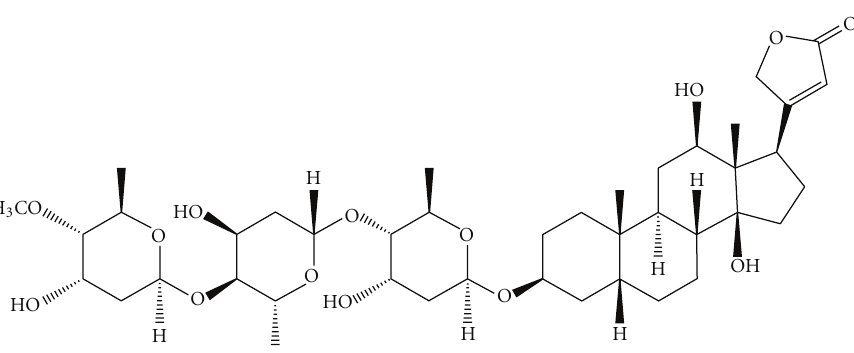
Figure 2: Chemical structure of metildigoxin (C 42 H 66 O 14